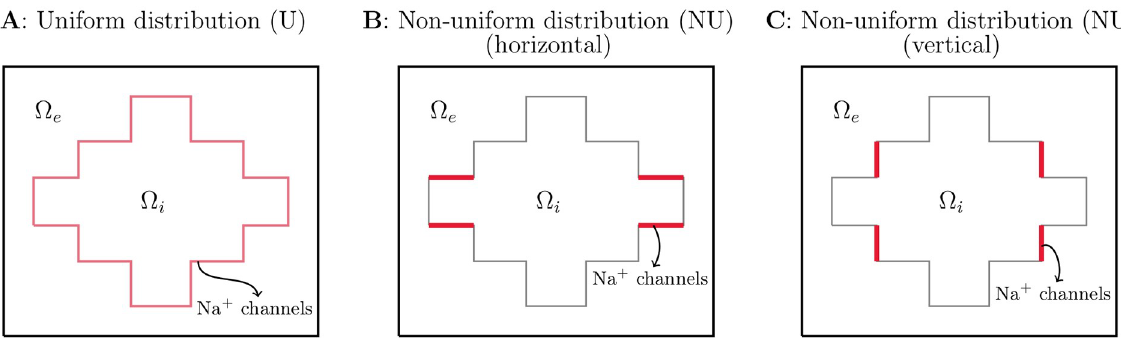
Fig 3. Illustration of three different spatial distributions of the sodium channels for a 2D single cell case. A: Uniform distribution. B: Non- uniform distribution with a high density of sodium channels at the horizontal part of the cell ends in the x -direction. C: Non-uniform distribution with a high density of sodium channels on the vertical part of the cell ends in the x